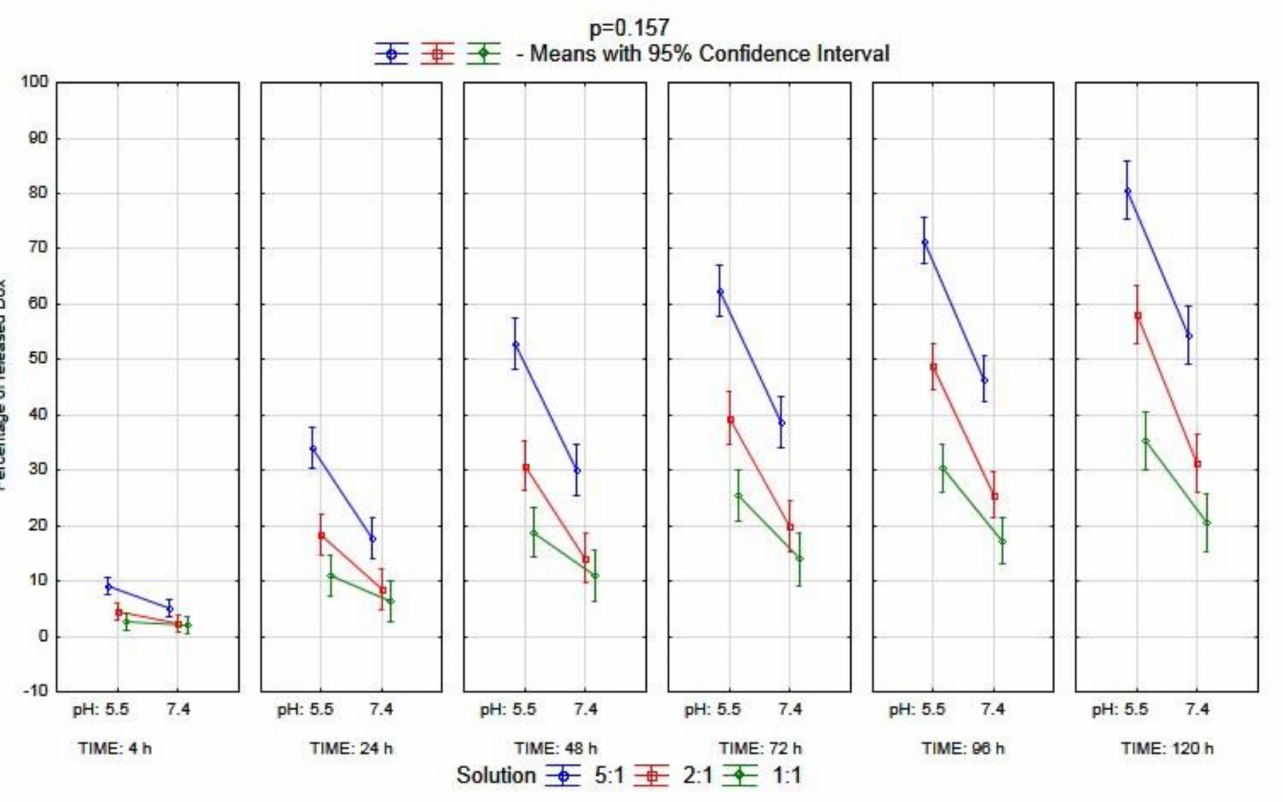
Figure 10. Multivariate analysis of the interaction between time, pH, and the molar ratio of BSA–CR–Dox on the percentage of the released Dox from the complex (n = 108, n = number for all of the